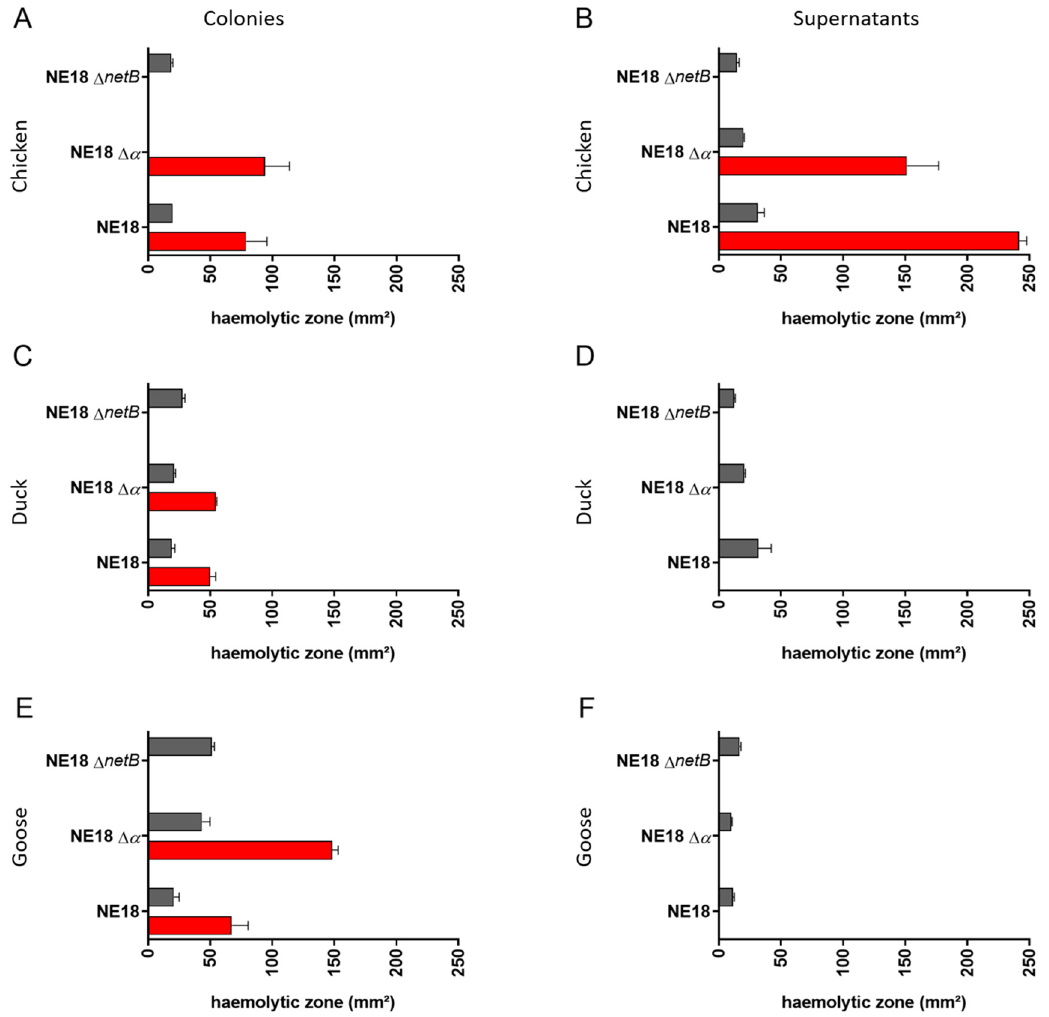
Figure 2. Inner and outer haemolysis induced by C. perfringens strain NE18, its NetB mutant (NE18 ∆ netB ) and its alpha toxin mutant (NE18 ∆ α ) on Columbia agar supplemented with blood from different avian species (( A , B ): chicken blood; ( C , D ): duck blood; ( E , F ): goose blood). Comparison of haemolysis induced from colonies (left column; ( A , C , E )) or supernatants (right column; ( B , D , F )) was assessed. Grey bars indicate inner haemolysis while red bars represent outer haemolytic zone.